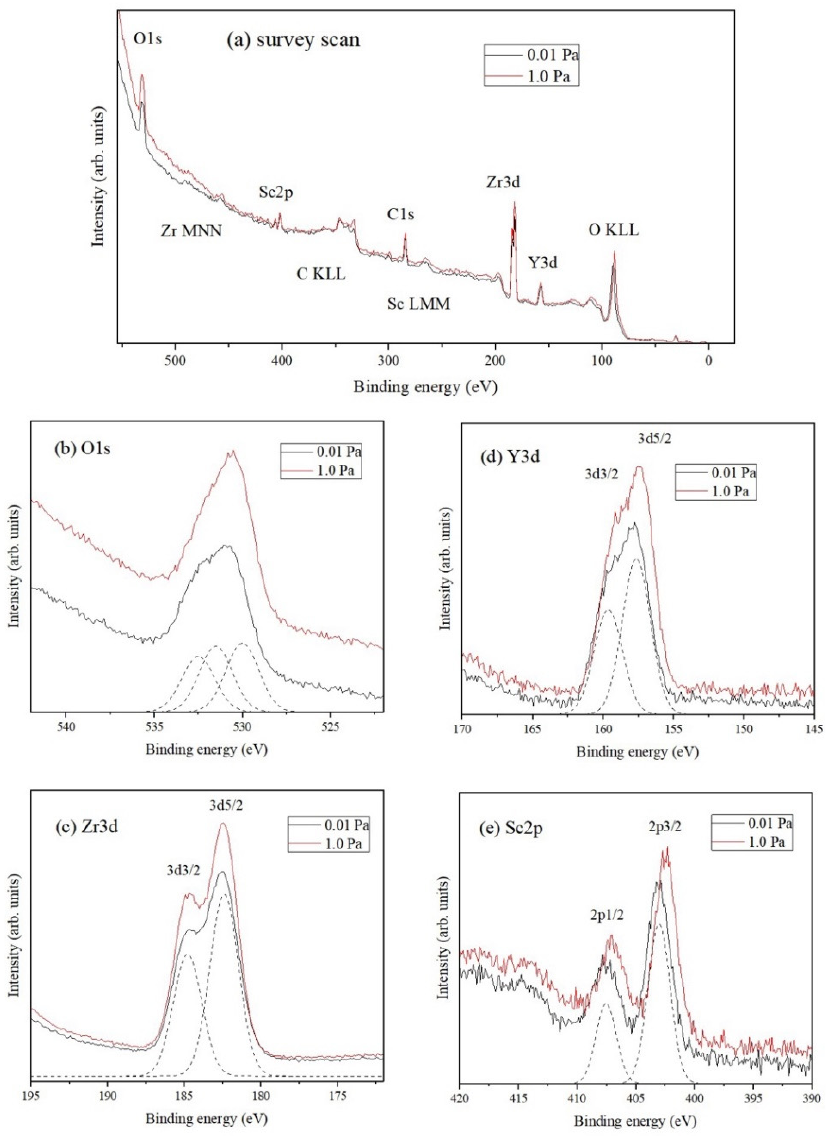
Figure 5. ( a ) PES wide scan spectra of ScYSZ thin film on SiO 2 -Si substrate prepared at T s = 600 °C with P O = 0.01 Pa and P O = 1.0 Pa, and ( b – e ) comparative stack spectra with P O 2 = 1.0 Pa showing the ( b ) O 1s, ( c ) Zr 3d, ( d ) Y 3d, and ( e ) Sc 2p core levels.